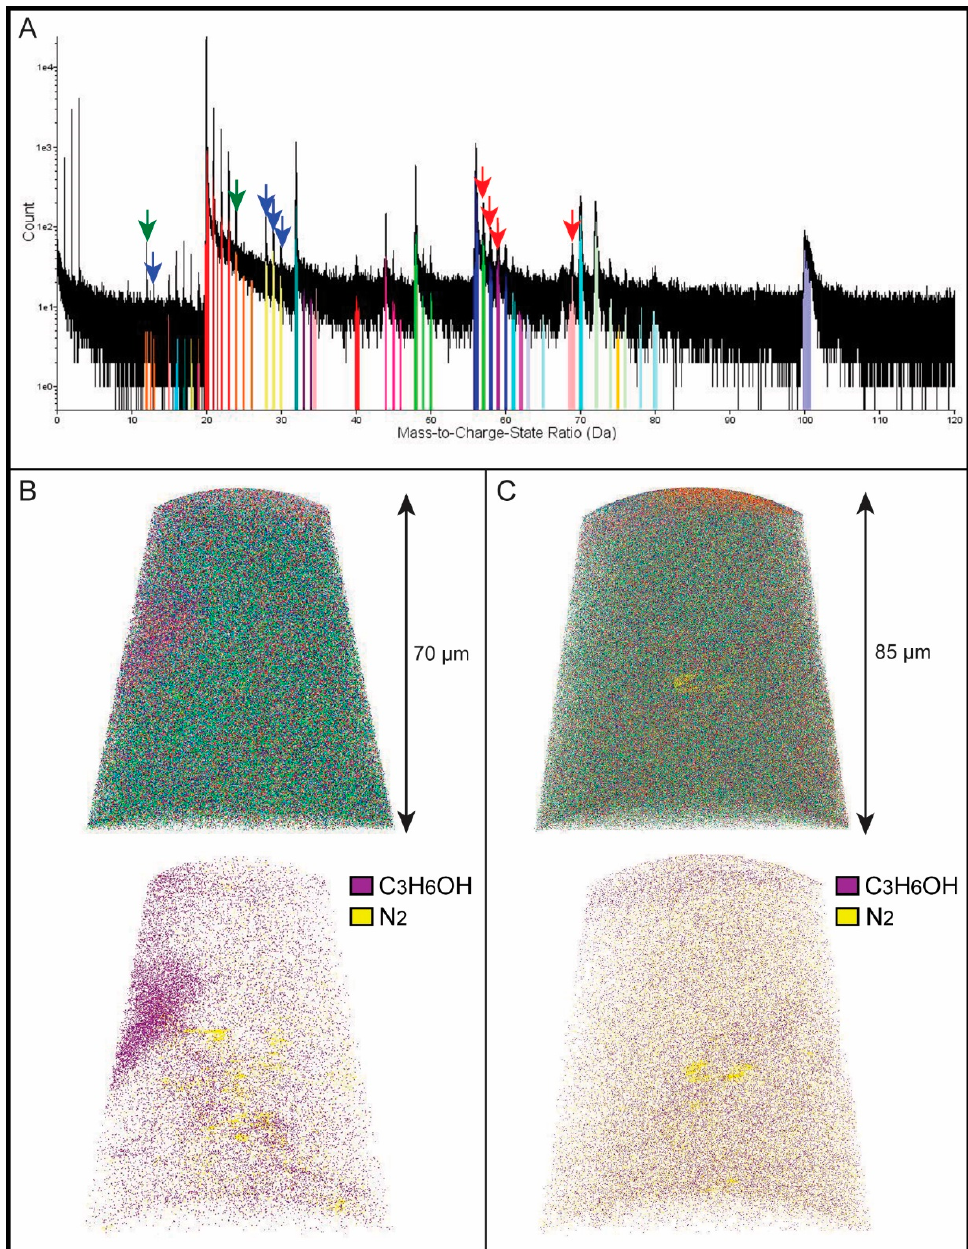
Figure 4. Example of APT results. ( A ) Example of a typical mass spectrum for all of the tips analyzed from wedges 7 and 8, indicating the location of the peaks for magnesium (green arrows), N compounds (blue arrows), and C compounds (red arrows). Note: For complete identification of peaks, see Table 2. ( B ) Example of a 3D tip reconstruction of tip M20 (from W7) for all ions (top) and ions corresponding to the peaks identified as C 3 H 6 OH and N 2 (bottom). ( C ) Example of a 3D tip reconstruction of tip M3 (from W8) for all ions (top) and ions corresponding to the peaks identified as C 3 H 6 OH and N 2 (bottom).